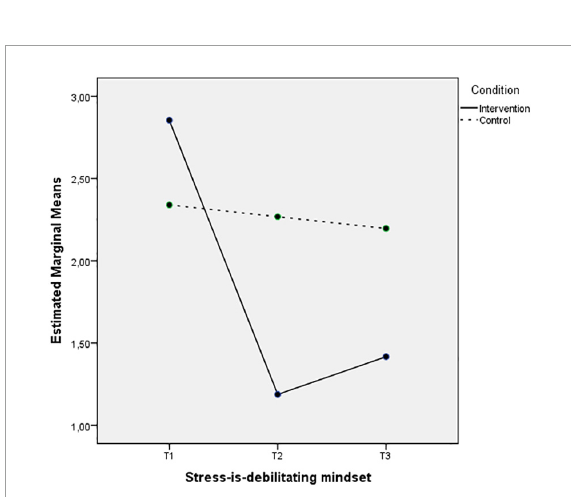
FIGURE4 Mean of negative emotions showing time effects on the two